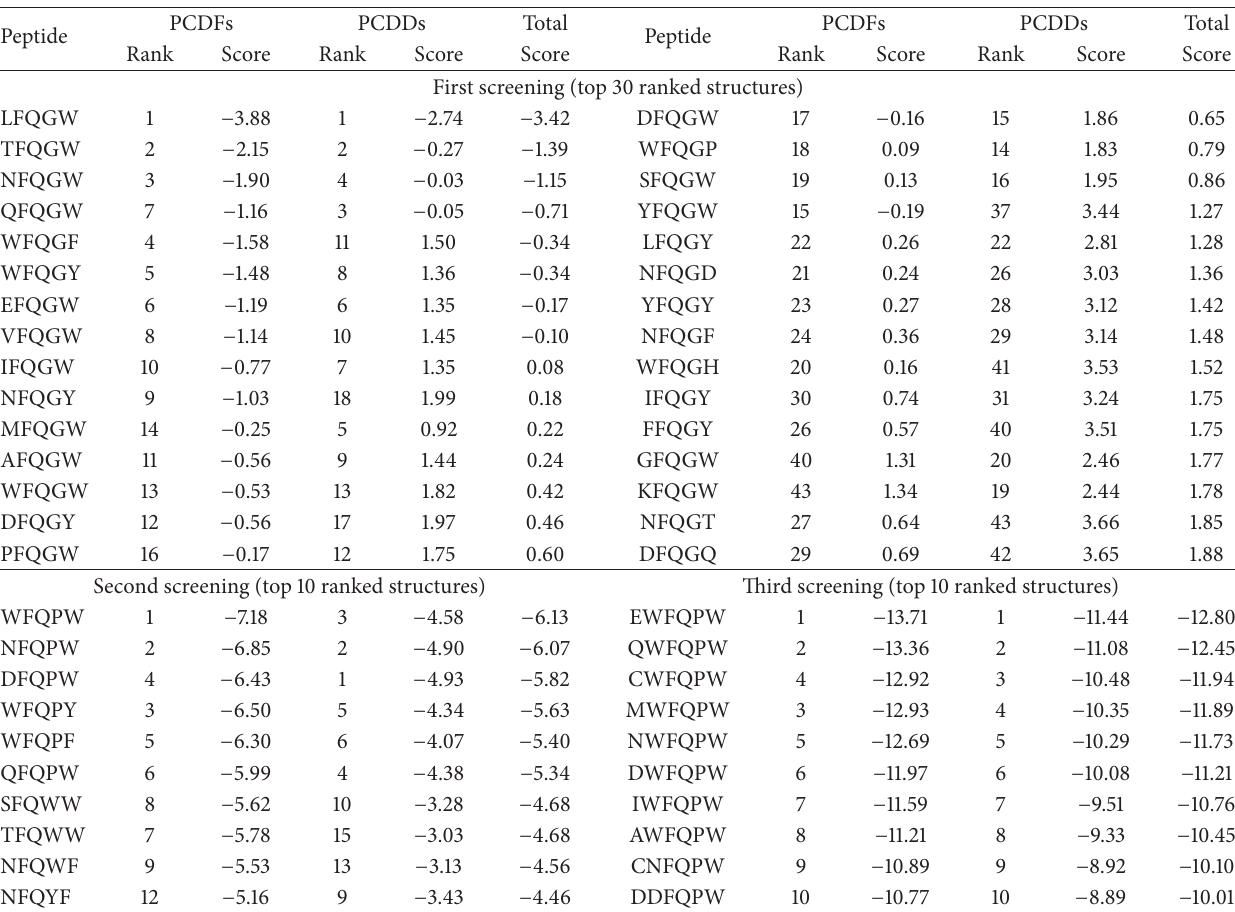
Table 1: Top ranked peptides selected after each screening step. Peptide-ligand complex average binding score was calculated using 10 conformers for each peptide versus all the 189 ligands. Peptides were sorted by average binding score over all the 189 ligands. The peptides rank and binding score versus the 113 PCDFs or the 76 PCDDs were also reported (rank and score columns). In parentheses the number of structures selected after each screening